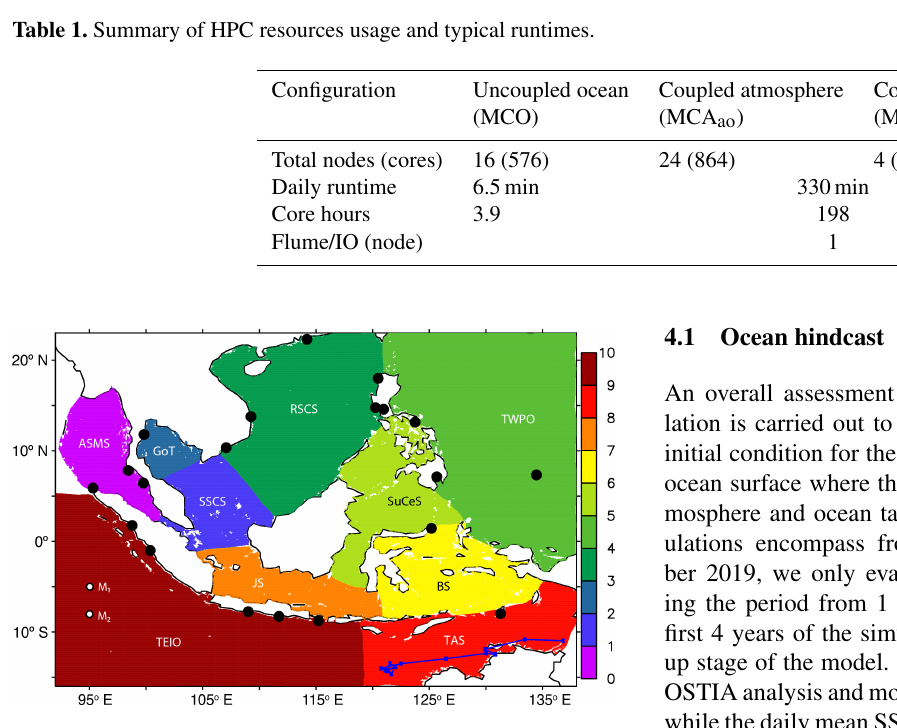
Figure 3. Domain used for hindcast and forecast evaluation with sub-regions defined in the study: (1) Andaman Sea–Malacca Strait (ASMS), (2) southern South China Sea (SSCS), (3) Gulf of Thai- land (GoT), (4) the rest of the South China Sea (RSCS), (5) the tropical western Pacific Ocean (TWPO), (6) Sulu–Celebes seas (SuCeS), (7) Banda Sea (BS), (8) Java Sea (JS), (9) Timor–Arafura seas (TAS), and (10) the tropical eastern Indian Ocean (TEIO). The Bay of Bengal region (north of 5 ◦ N, west of 92 ◦ E) is excluded when analysis is performed for different sub-regions. The blue line in the TAS indicates the TSG observation track. The locations of tide gauges are shown as black circles. Moored buoy locations M 1 (5 ◦ S, 95 ◦ E) and M 2 ( 8 ◦ S, 95 ◦ E) are also shown.